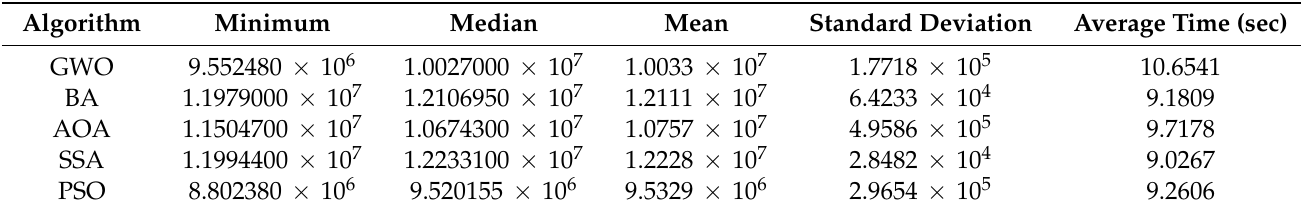
Figure 7. Boxplots of the Optimal Fitness Values from the 250 Simulations. Table 2. Comparison of Fitness Values Obtained by Metaheuristics and Average Execution